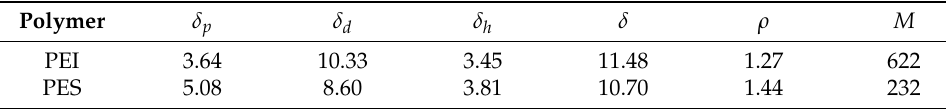
Figure 14. Enthalpy of mixing for blending system. Table 7. Main parameters of blend